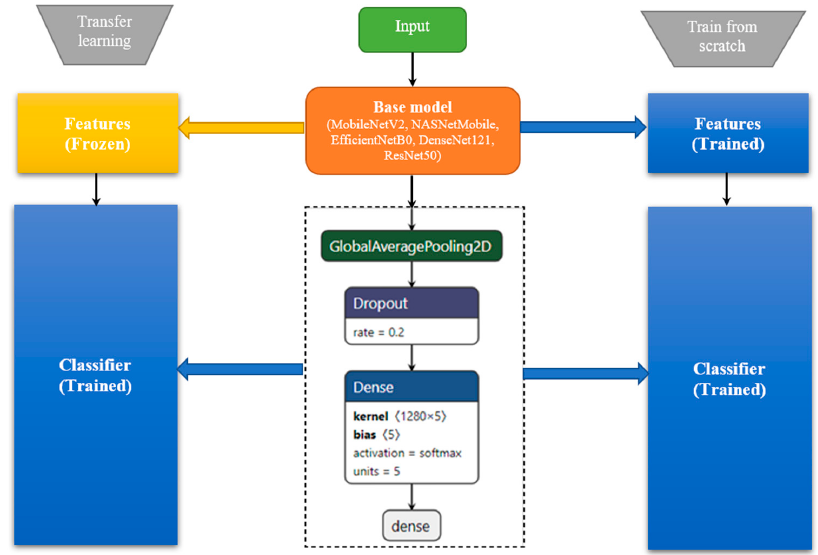
Figure 4. Transfer learning vs. train from scratch paradigm.